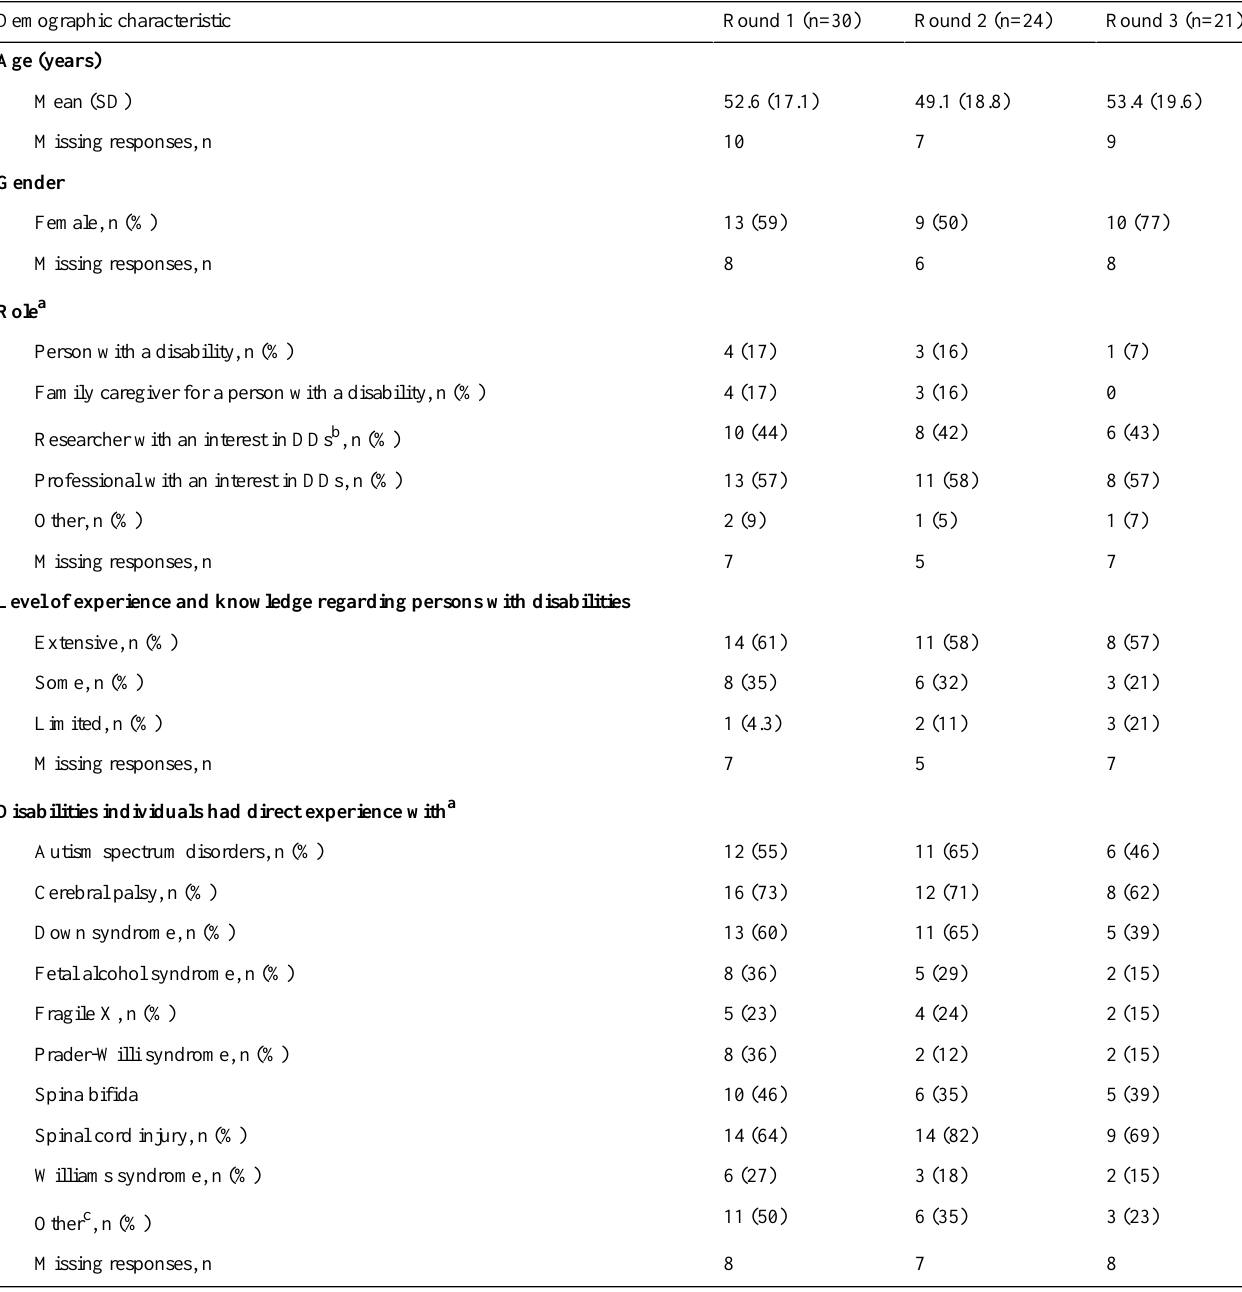
Table 1. Characteristics of respondents of each of the 3 Delphi